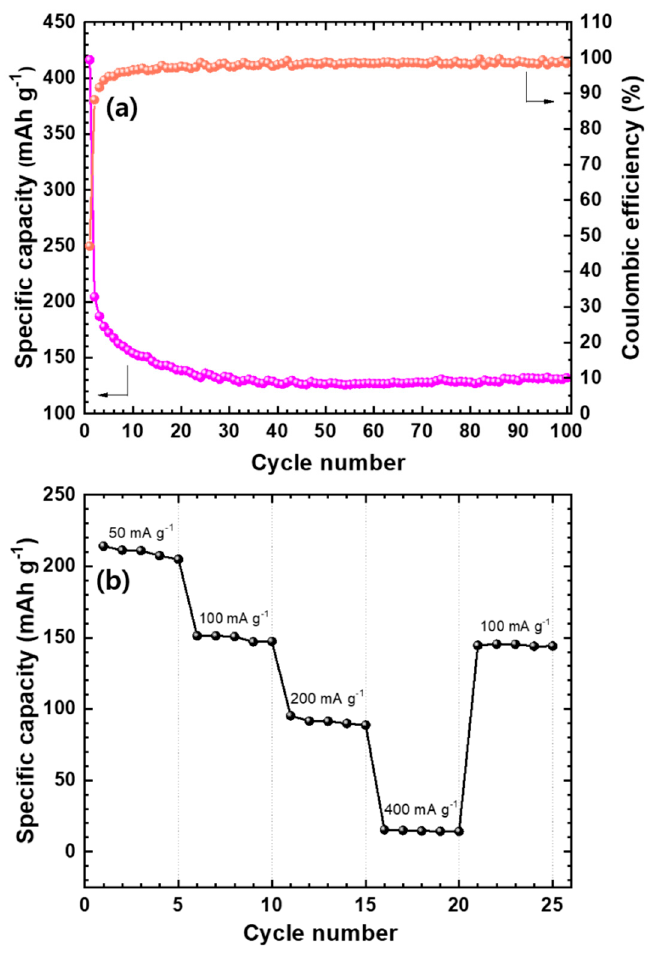
Figure 8. ( a ) Coulombic efficiency and battery cycling for Mo 2 C@CNT hybrid anode at 50 mA · g − 1 ; ( b ) Rate capability profile at different current densities (50, 100, 200, and 400 mA · g − 1 ) for the Mo 2 C@CNT hybrid anode.